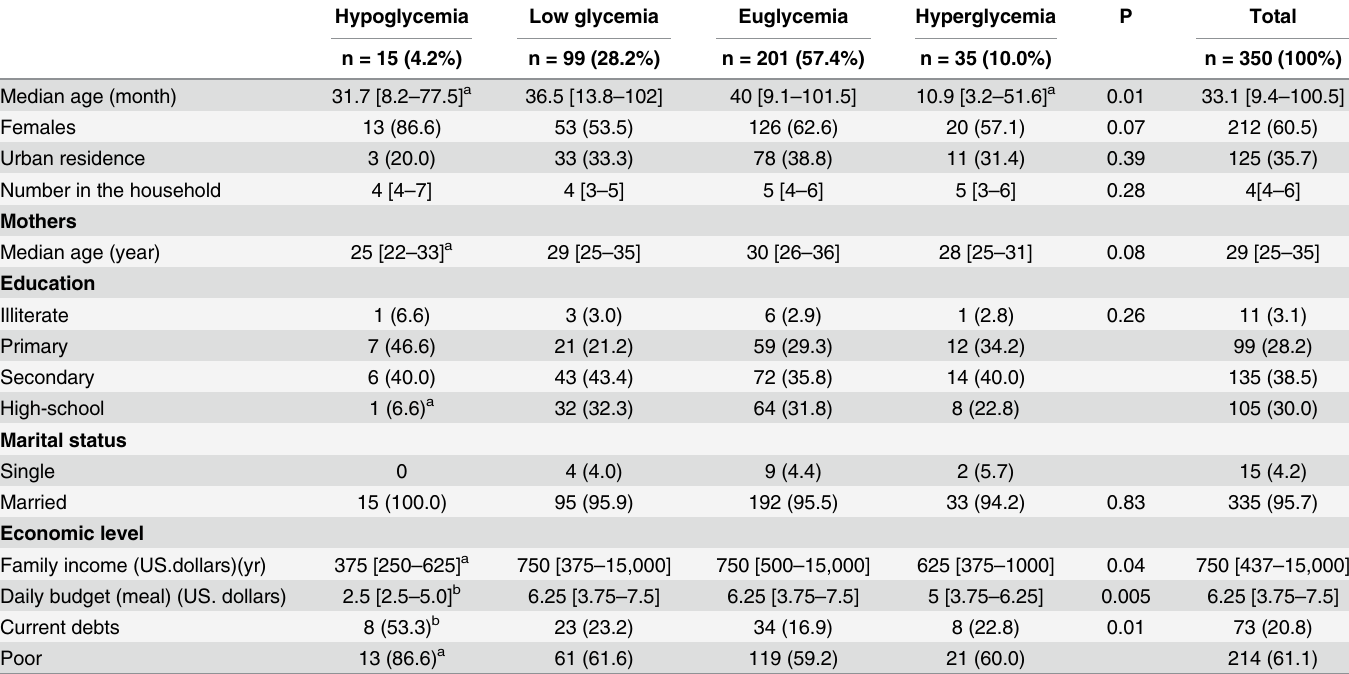
Table 2. Socio-demographic characteristics of sick children admitted to Vientiane hospital and their